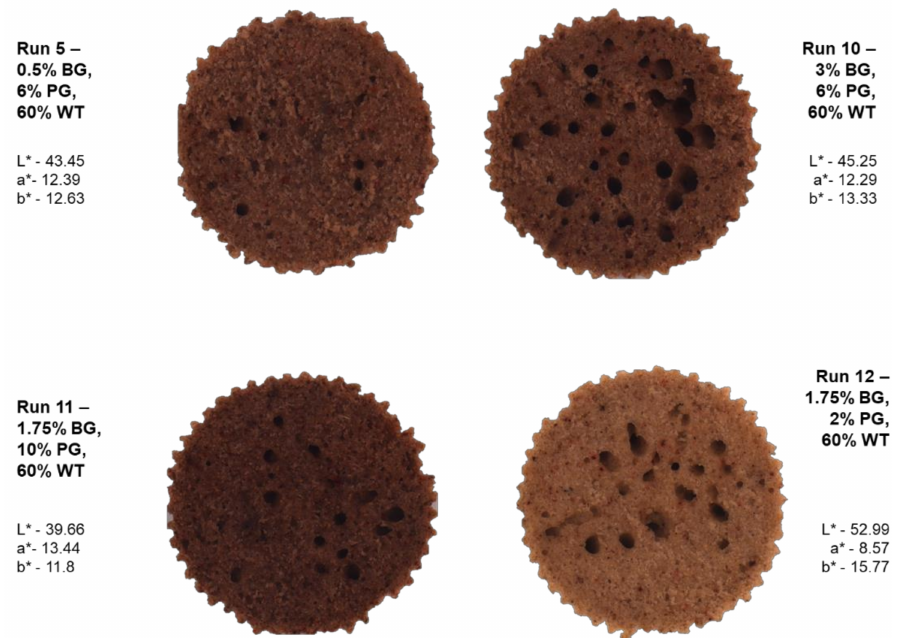
Figure 1. Pictures of cross-sections of muffins with different levels of pomegranate powder, water, and oat β -glucan. BG— β -glucan, PG—pomegranate,